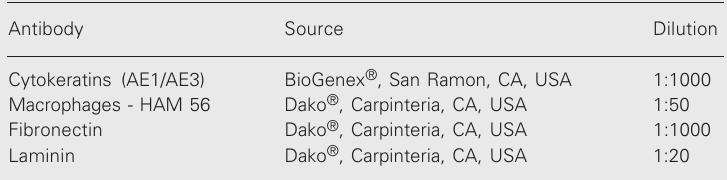
Table 2. Primary antibodies used for immunohistochemical staining of the skin of hr USP mutants and BALB/c mice, and their dilutions.